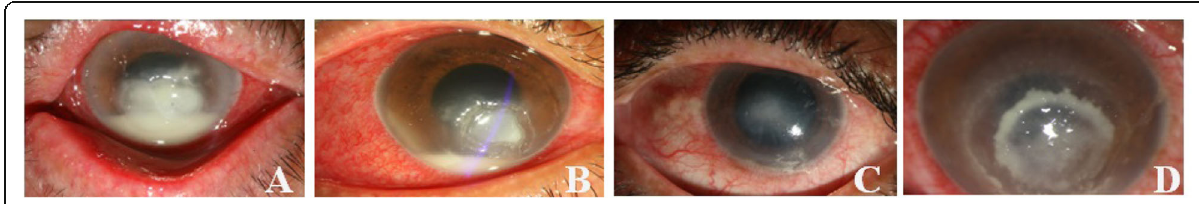
Fig. 1 Slit-lamp photographs of patients. Hypopyon can be seen in the anterior chamber of patient 1 ( A ) and patient 2 ( B ), A grayish, superficial stromal infiltrate with indistinct margins can be seen in patient 3 ( C ) patient 4 ( D )